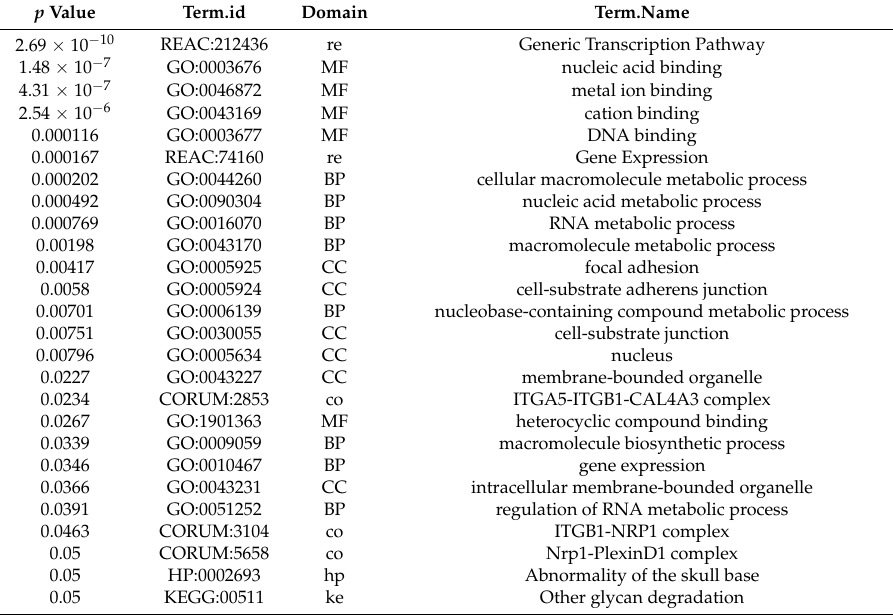
Table 3. Functional gene groups significantly different between gliosarcoma ans glioblastoma samples. re—REACTOME, MF—GO molecular function, BP—GO biological process, CC—GO cellular component, co—CORUM, hp—Human Phenotype Ontology,